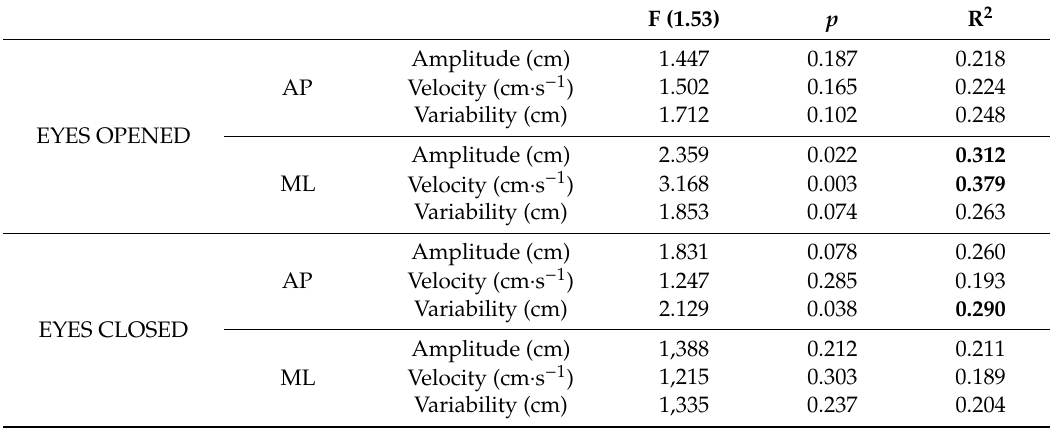
Table 3. Characteristics of the multiple regression models according to the predicted balance outcomes.